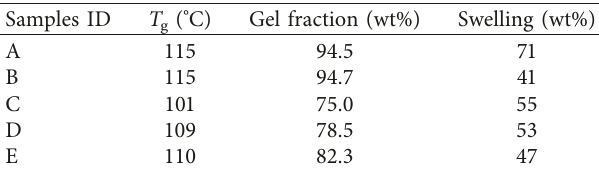
Table 2: Glass transition temperature ( T swelling